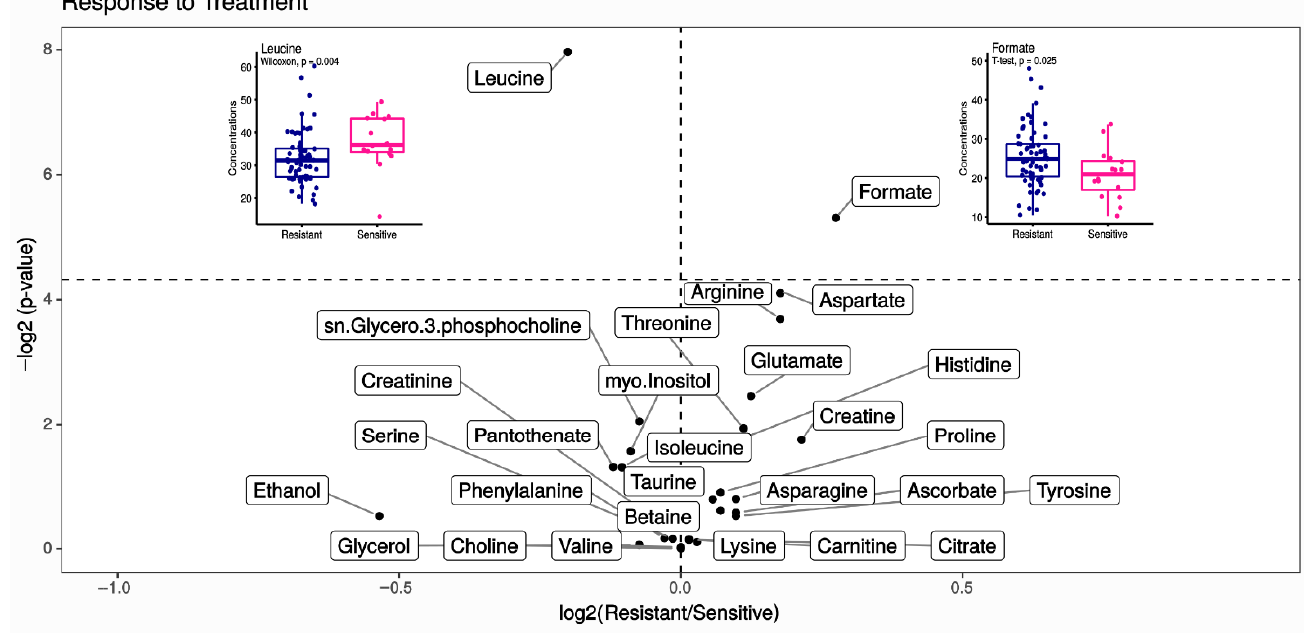
Figure 2. Volcano plot showing the metabolite variation by NACT outcomes (log2(resistant/sensitive)) in function of their statistical significance (log2( p -value)). Non-significant metabolites are plotted below the horizontal dashed line, and the metabolites above this line presented significant variation ( p -value < 0.05). In addition, we show a boxplot for metabolites with significant variation (blue